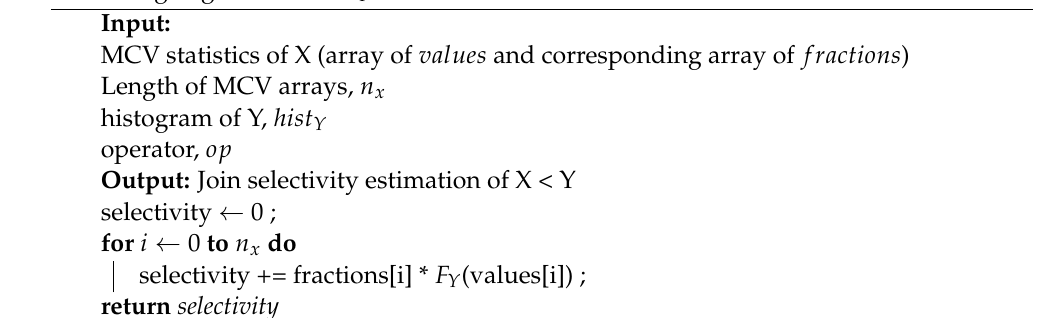
Algorithm 5: Join selectivity estimation algorithm for the less than (<) operator re-using Algorithm 1 as F Y